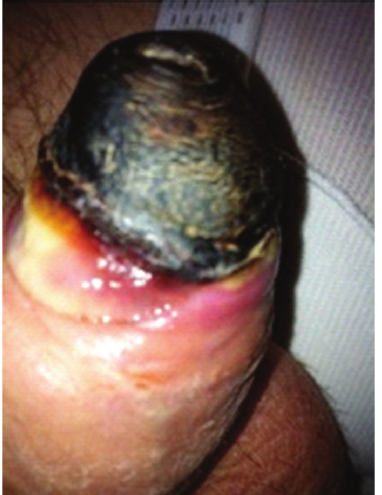
Figure 3: Avascular necrosis of the glans.